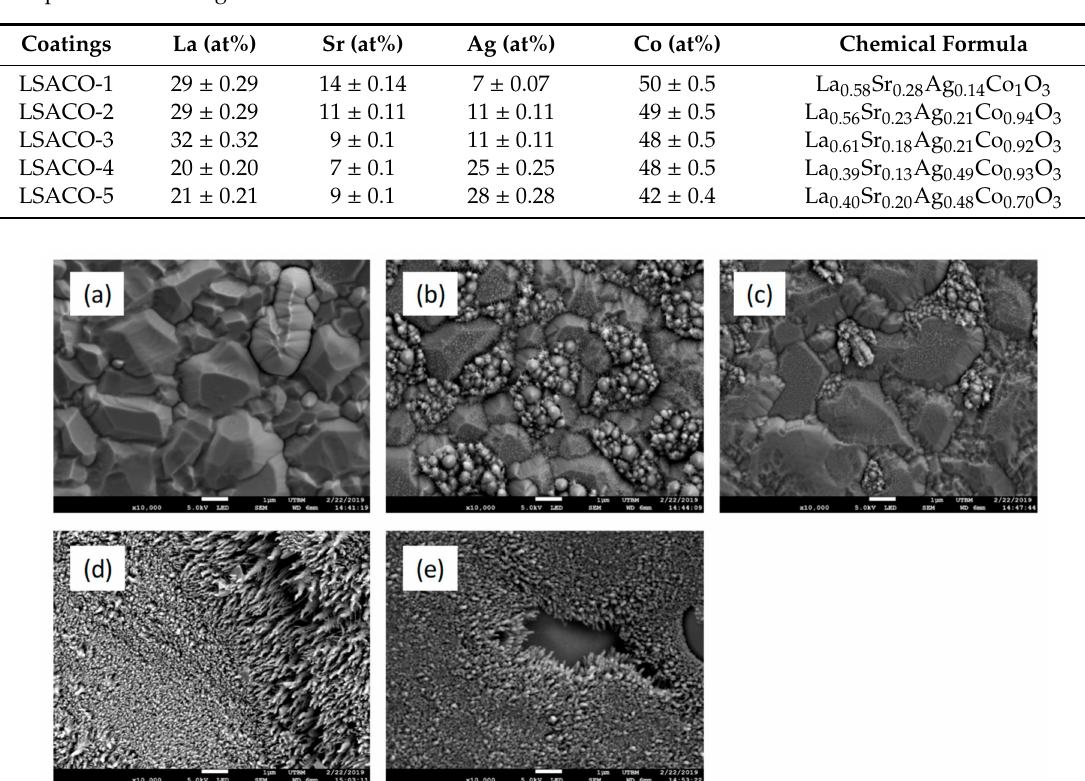
Table 3. Chemical composition determined by EDS of the as-prepared La 1-x-y Sr x Ag y CoO 3- α (LSCAO) perovskite coatings.